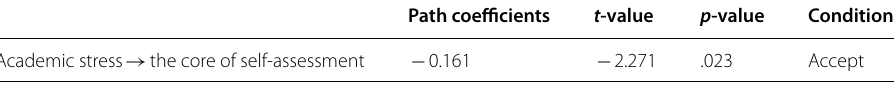
Significant at the level of 0.01 ( p <